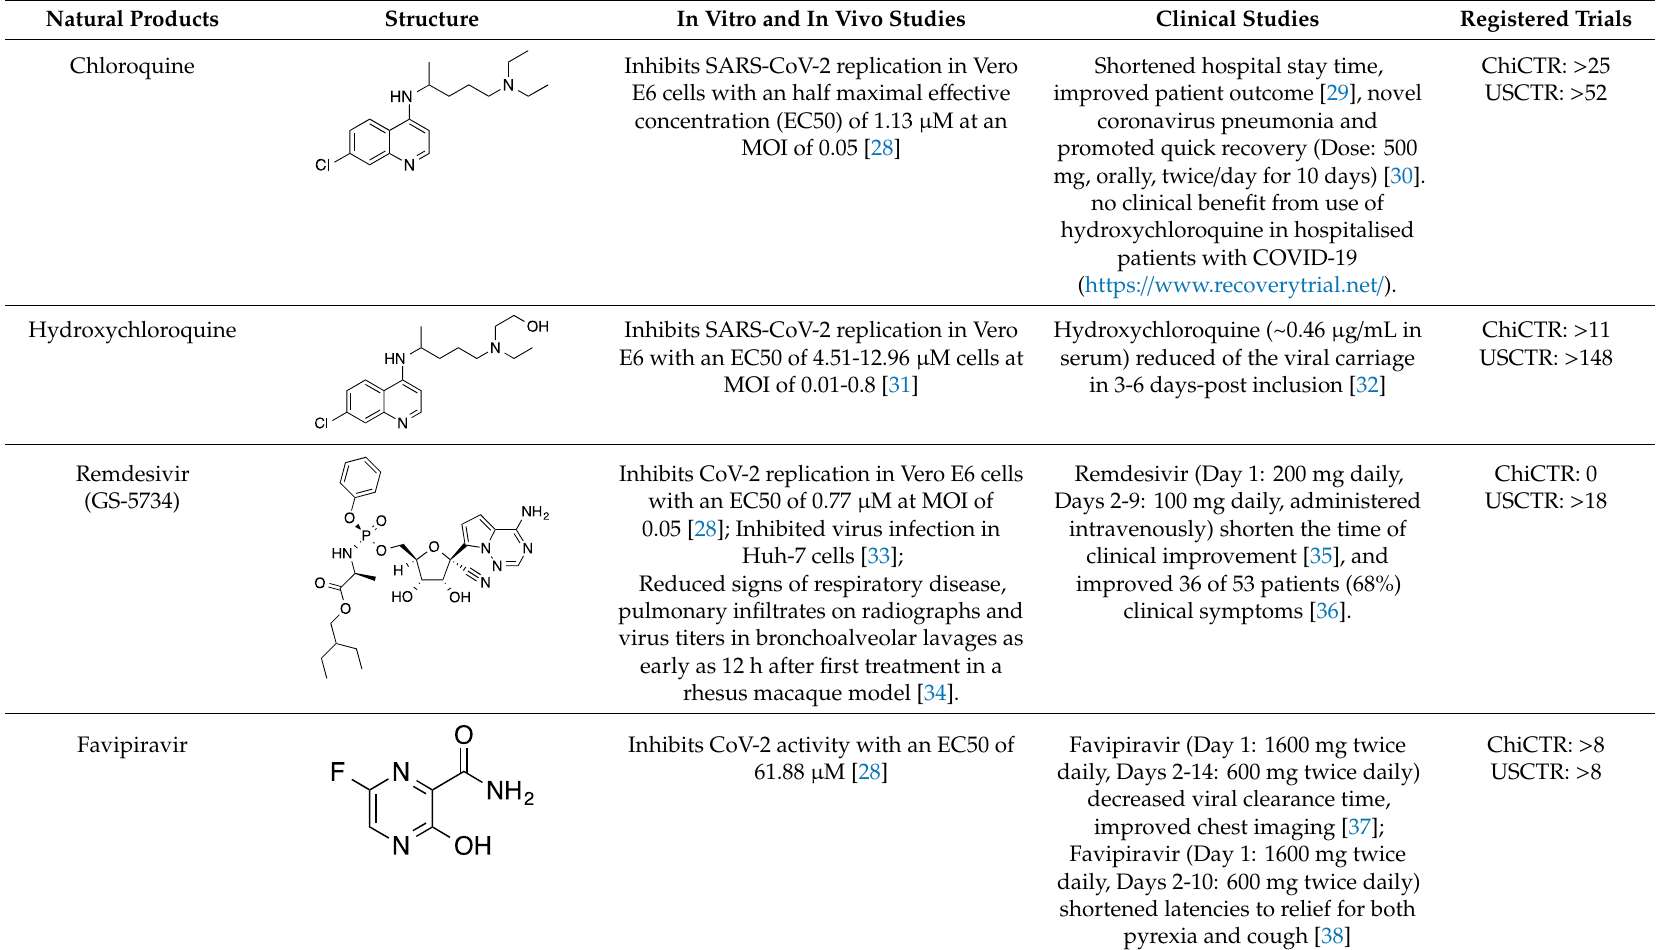
Table 1. Natural products, their derivatives or mimics fighting COVID-19.